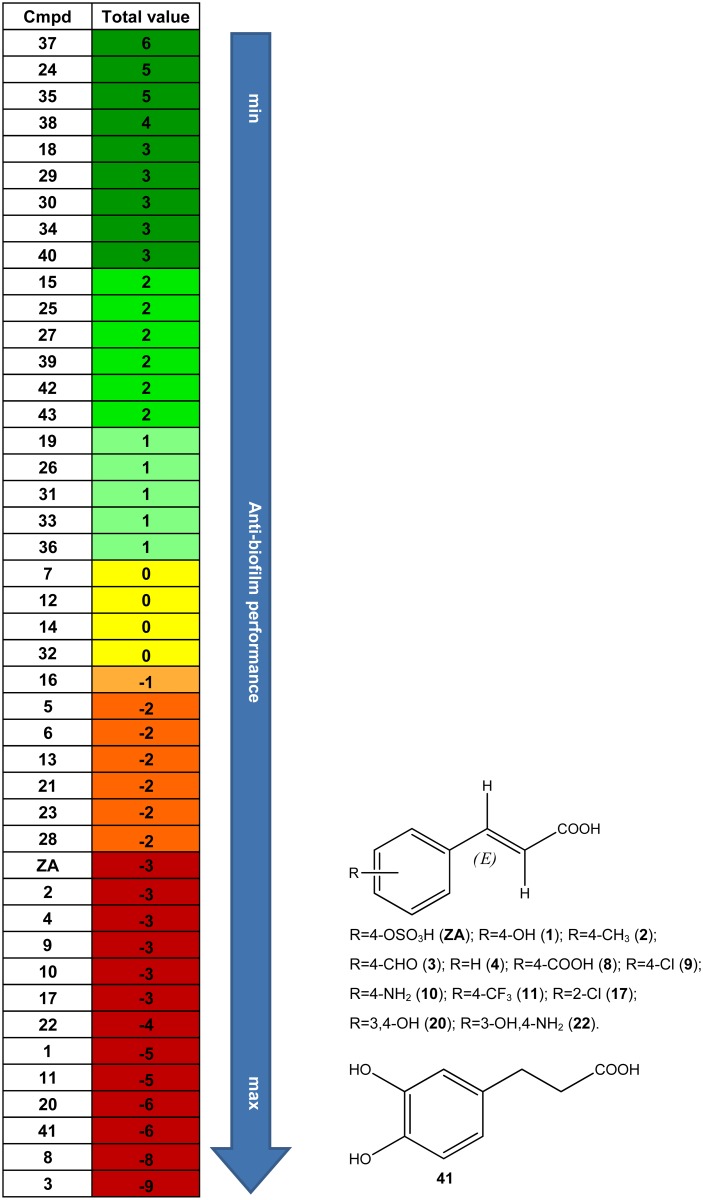
Global anti-biofilm performance of ZA-related compounds and structures with the most significant anti-biofilm performance.Global anti-biofilm performance value of each ZA-related compound calculated as (sum of cell adhesion codes of all concentrations)-(sum of planktonic growth codes of all concentrations). Values equal to 0 were considered without anti-biofilm performance, below 0 were considered globally able to exert an anti-biofilm activity, and above 0 were considered able to improve biofilm performance. Yellow: no anti-biofilm performance; Light orange: little anti-biofilm performance; Medium orange: moderate anti-biofilm performace; Dark orange: optimal anti-biofilm performance; Light green: little improvement of anti-biofilm performance; Medium green: moderate improvement of anti-biofilm performance; Dark green: optimal improvement of anti-biofilm performance.